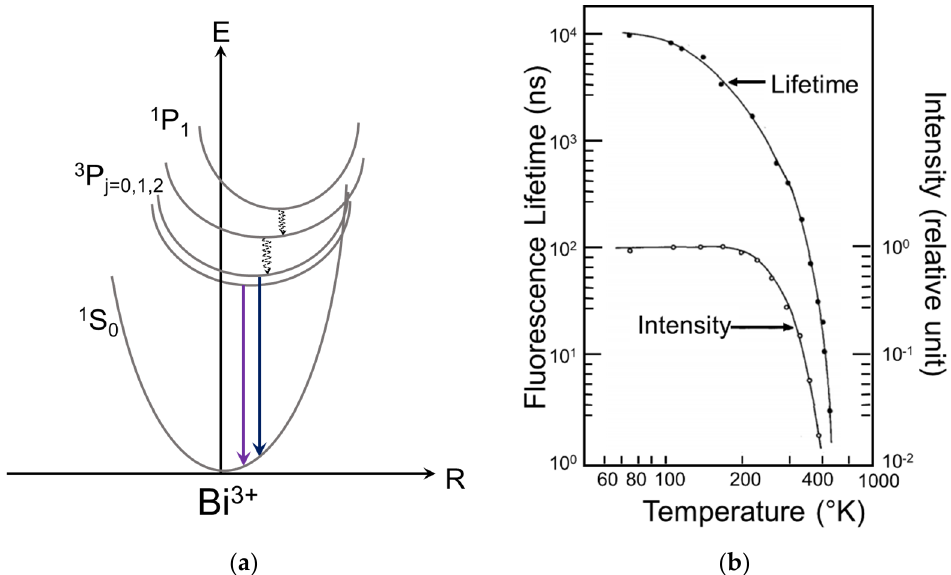
Figure 8. ( a ) Configurational coordinate diagram of the ground state and the excited state of Bi 3+ . ( b ) Temperature dependence of the fluorescence lifetime and intensity for BGO. Adapted from Reference [128].